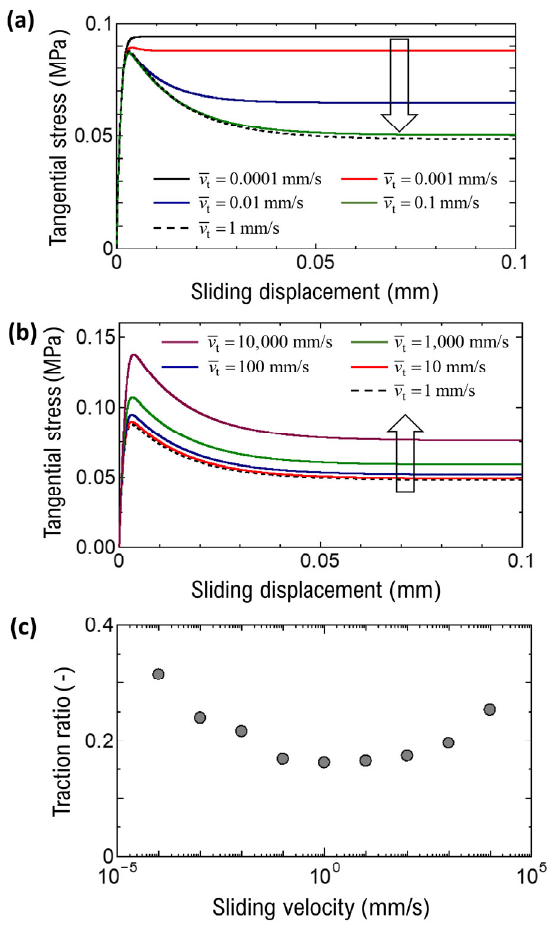
Fig. 4 Typical response of rate-dependent friction: (a) variation of tangential stress with sliding in the case of velocity-weakening; (b) variation of tangential stress with sliding in the case of velocity- strengthening; (c) relationship between steady state ratio of traction (friction coefficient) and sliding velocity. Here, the constant normal stress is set as f n = 0.3 MPa.